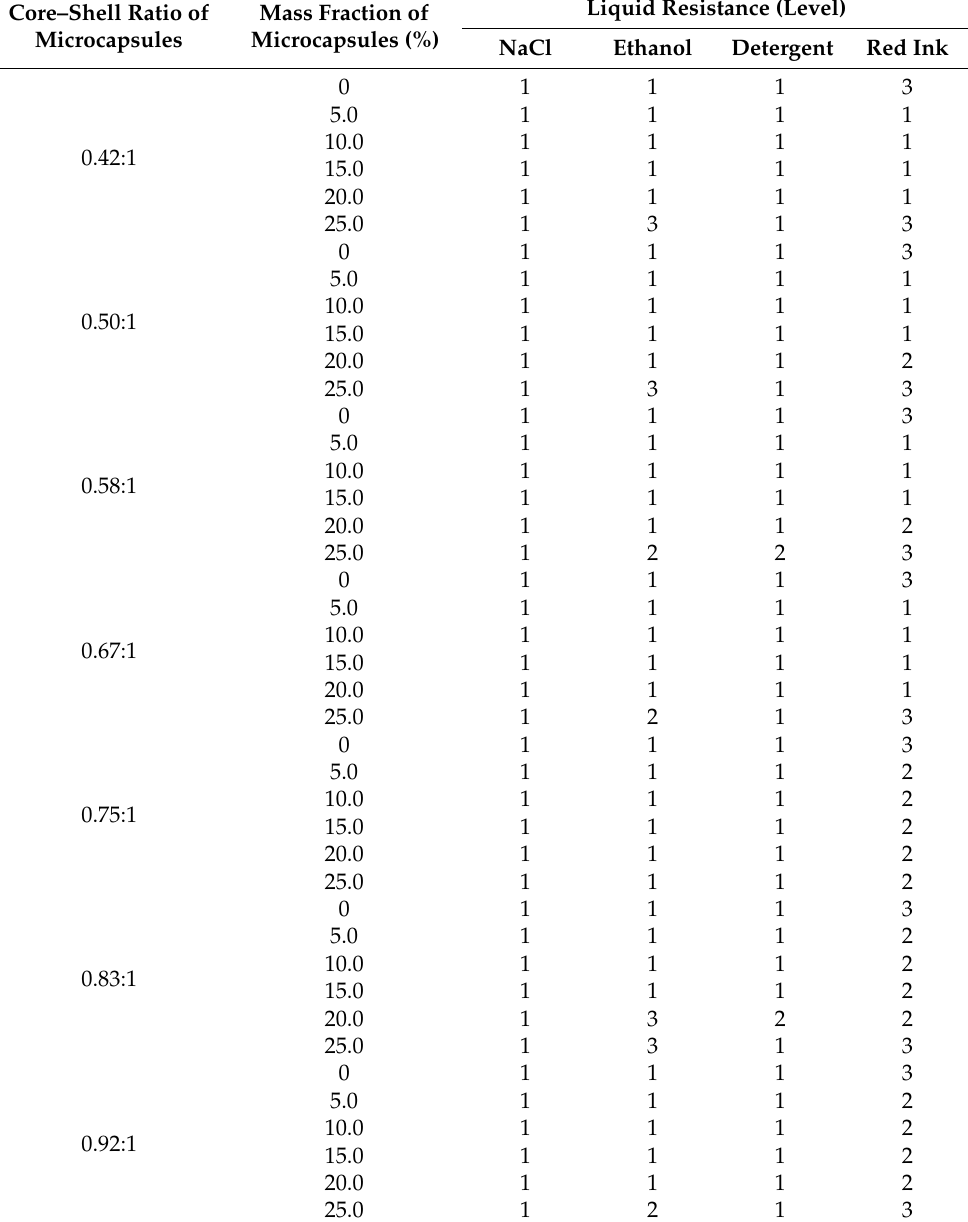
Table 9. Liquid resistance of the waterborne primer